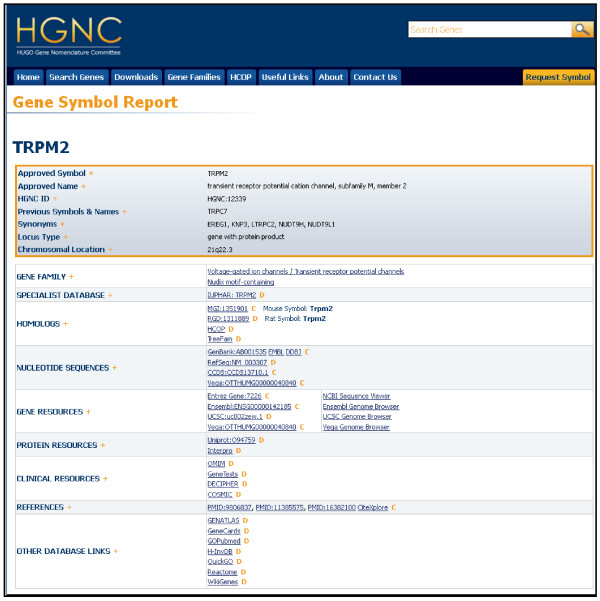
Gene Symbol Report forTRPM2.